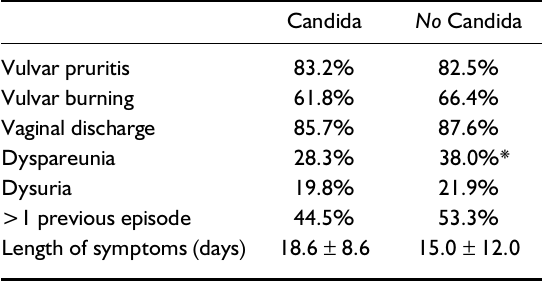
Table 2 Demographics of women with vulvovaginitis and a positive or negative culture for Candida